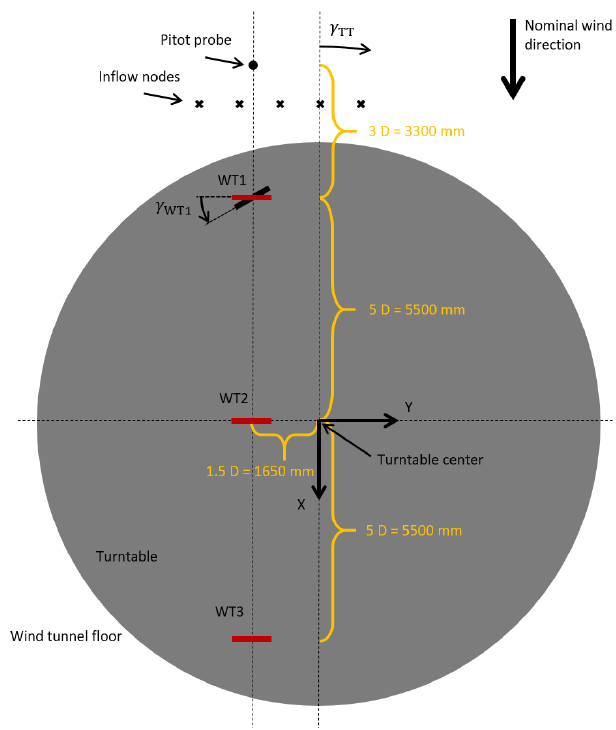
Figure 2. Wind farm layout for a null turntable rotation, looking down onto the wind tunnel floor.